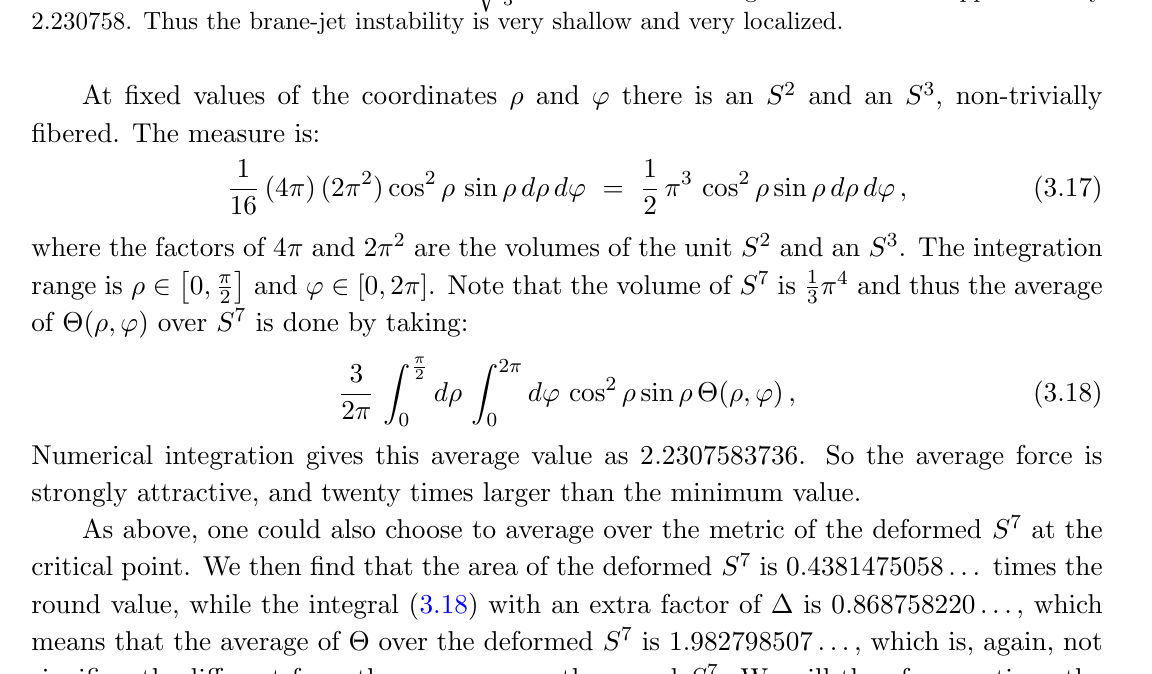
Figure 2 . Contour plot of (cid:2)( (cid:26); ’ ) with (cid:11) = 0 for the SO(3) (cid:2) SO(3) critical point. The brane-jet locus, J , is the interior of the region de(cid:12)ned by the bold white line. Note that while this region appears to have a moderate size, this is a distortion caused by the projection. The region, J actually p q 7 occupies slightly less than 0 : 4% of the S 7 . The minimum value of (cid:2) is 2 (cid:0) (cid:25) (cid:0) 0 : 1133, and 3 p p q 7 the maximum value of (cid:2) is 6 + 15 (cid:0) (cid:25) 4 : 7949. The average of (cid:2) over S 7 is approximately 3 2 : 230758. Thus the brane-jet instability is very shallow and very